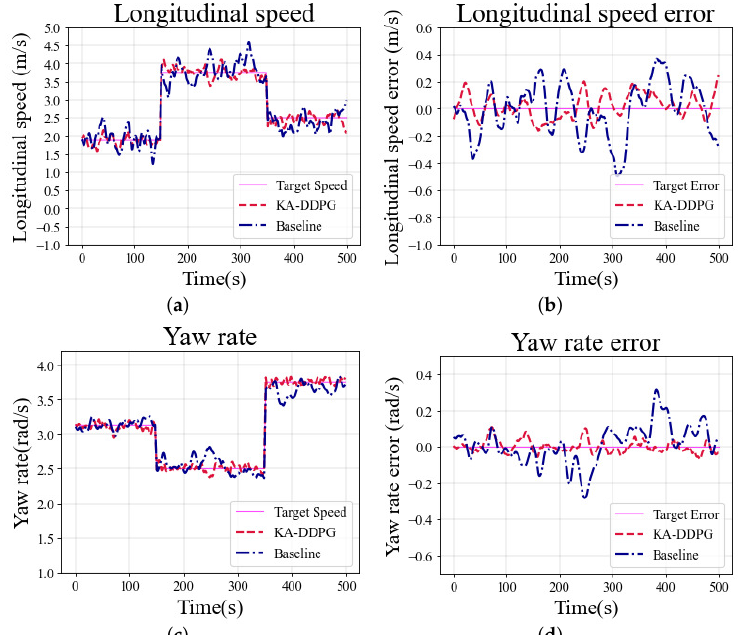
Figure 10. Tracking performance in the cornering scenario: ( a ) longitudinal speed tracking; ( b ) longi- tudinal speed error; ( c ) yaw rate tracking; and ( d ) yaw rate error.